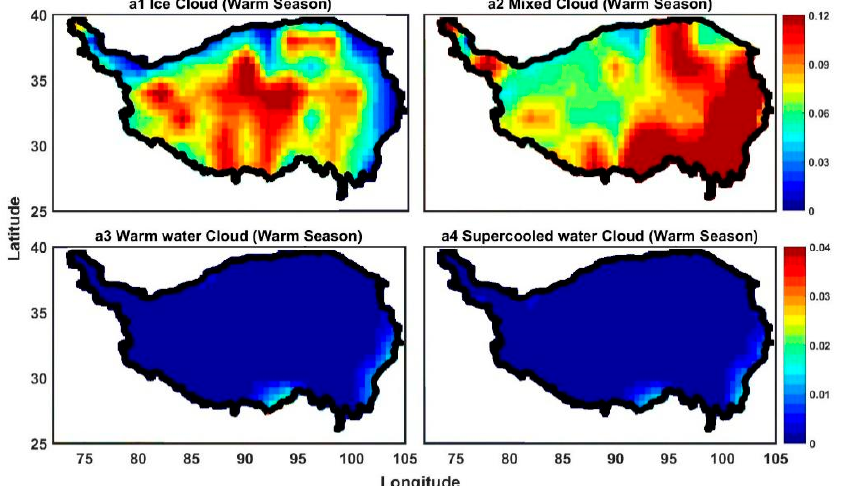
Figure 10. Precipitation frequency of the different cloud phases during the warm season (a1-a4 represent ice, mixed-phase, warm water, supercooled water clouds, respectively).